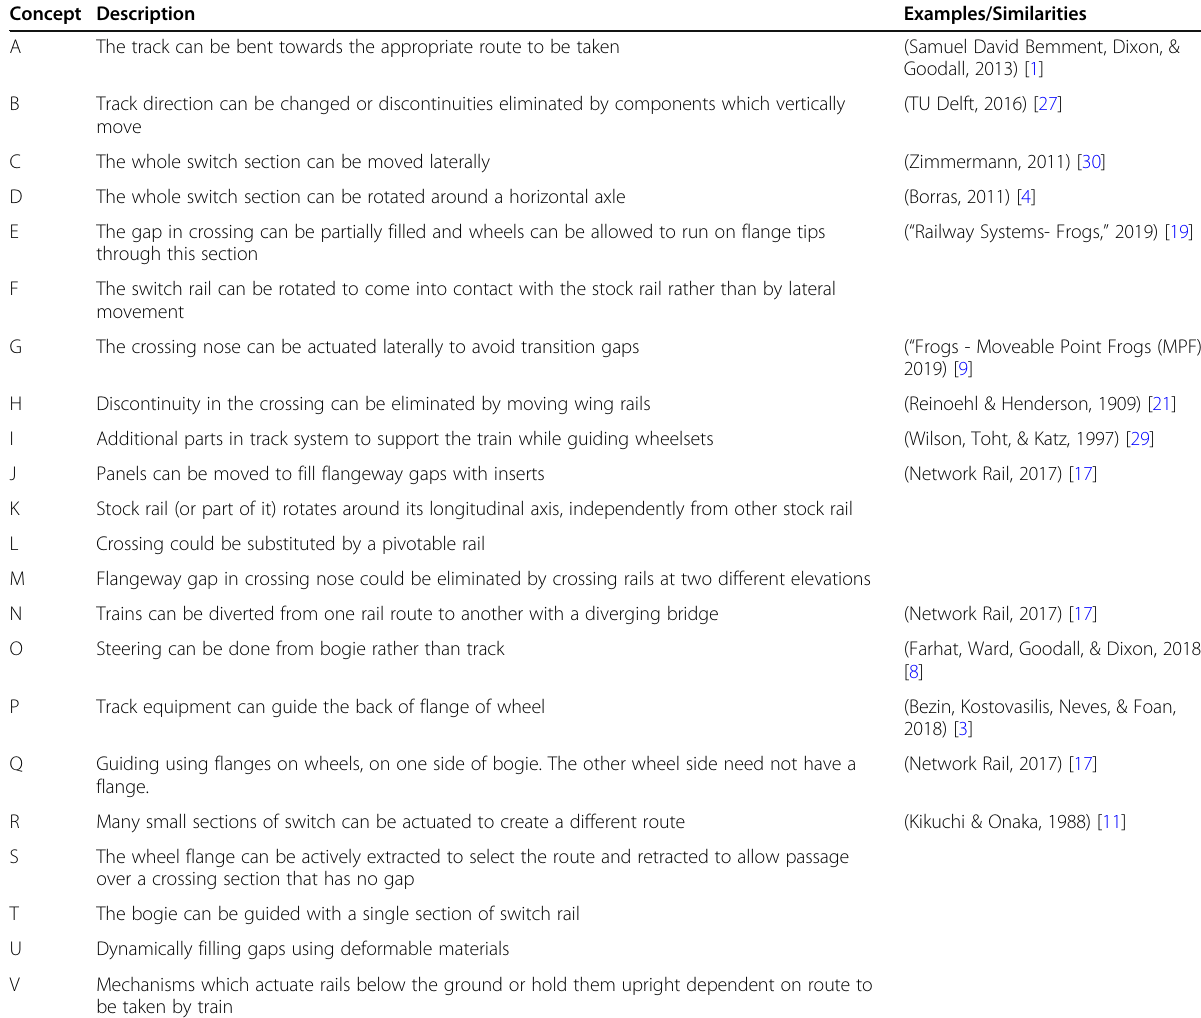
Table 1 List of devised concepts for novel S&C